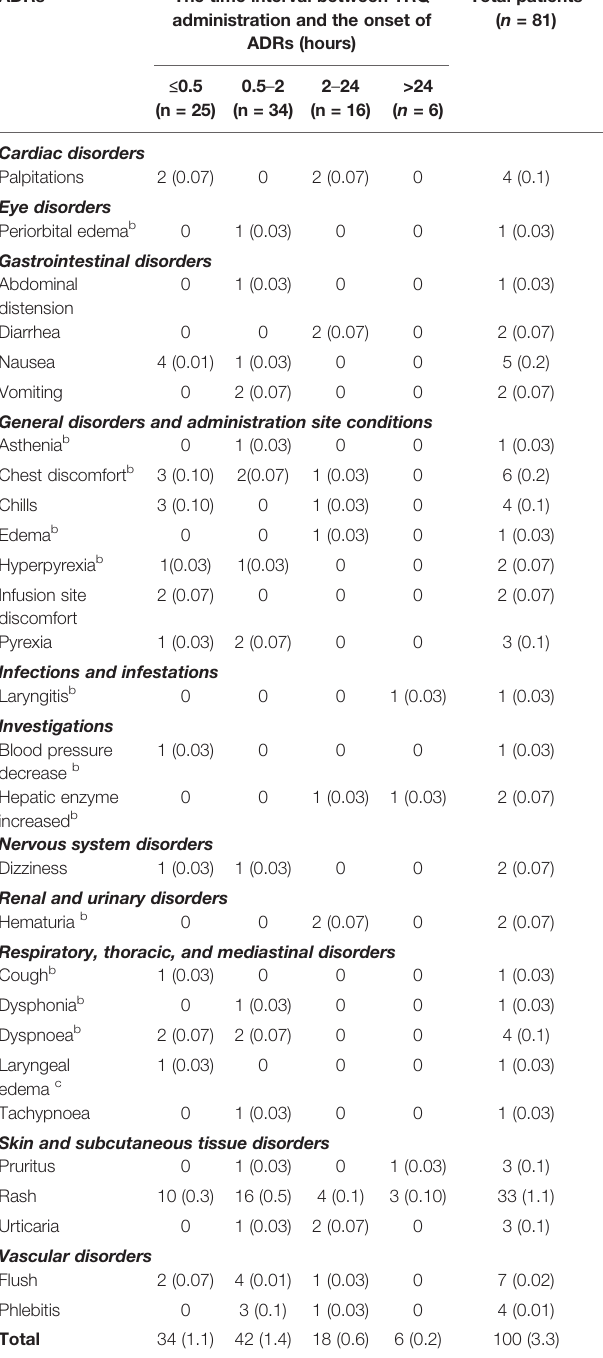
TABLE 3 | Frequency of Tanreqing injection-related adverse drug reactions according to the time of onset. Data are n ( ‰ ). ADRs The time interval between TRQ administration and the onset